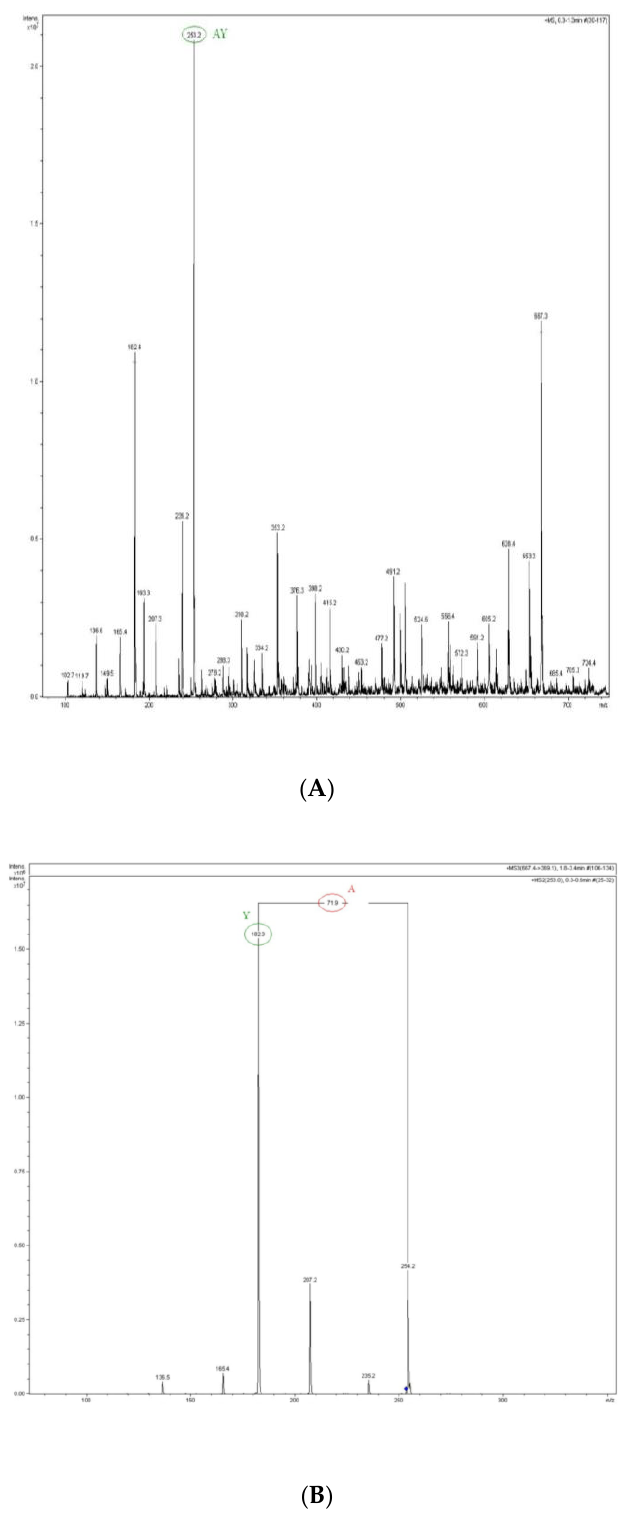
Figure 3. The MS ( A ) and MS/MS spectrum ( B ) of the peptide from fraction F8-2. According to Kou et al. (2013) [17], the lower-molecular-weight peptides (molecular mass from 200 to 3000 Da) are the most efficient antioxidants, and bioactive peptides usually contain less than 20 amino acid residues per molecule. The peptides with lower molecular weight have a better chance to cross the intestinal barrier and to exert biological effects. The Ala-Tyr peptide with the greatest